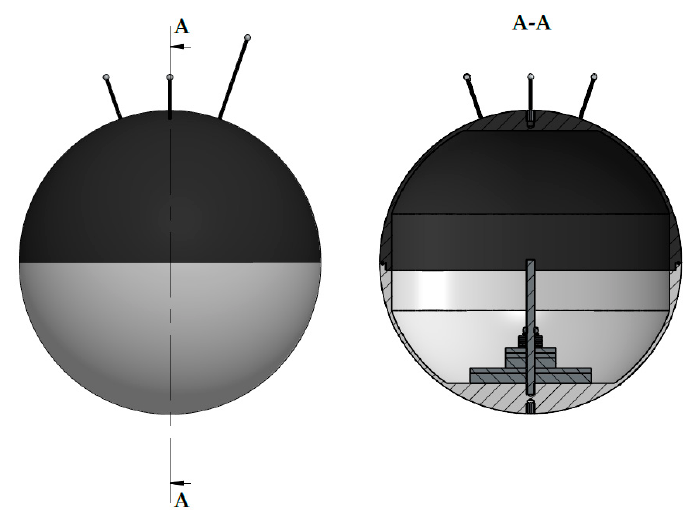
Figure 7. The sphere model after installation of reflective markers, ballasts, and rubber gaskets. The machined components (i.e., the hemisphere shells and the ballast weights), were constructed with a precision of 0.1 mm. The dimensions of the additional components (i.e., nuts and reflective markers), were known with the same precision. The weight of each of the individual components of the sphere model was measured on precision scales with a precision of 0.1 g. A 3D computer-aided design (CAD) drawing of the sphere model was created in which densities were ascribed to the individual components from the measured weights. The total mass, total center of gravity (in the local coordinate system defined in Section 1.1), and total moments of inertia of the sphere model installed with ballast to generate half-submergence are given in Table 2. In the Supplementary Materials under the Descriptions folder, the dimensions, weights, and centers of gravity are given for all individual